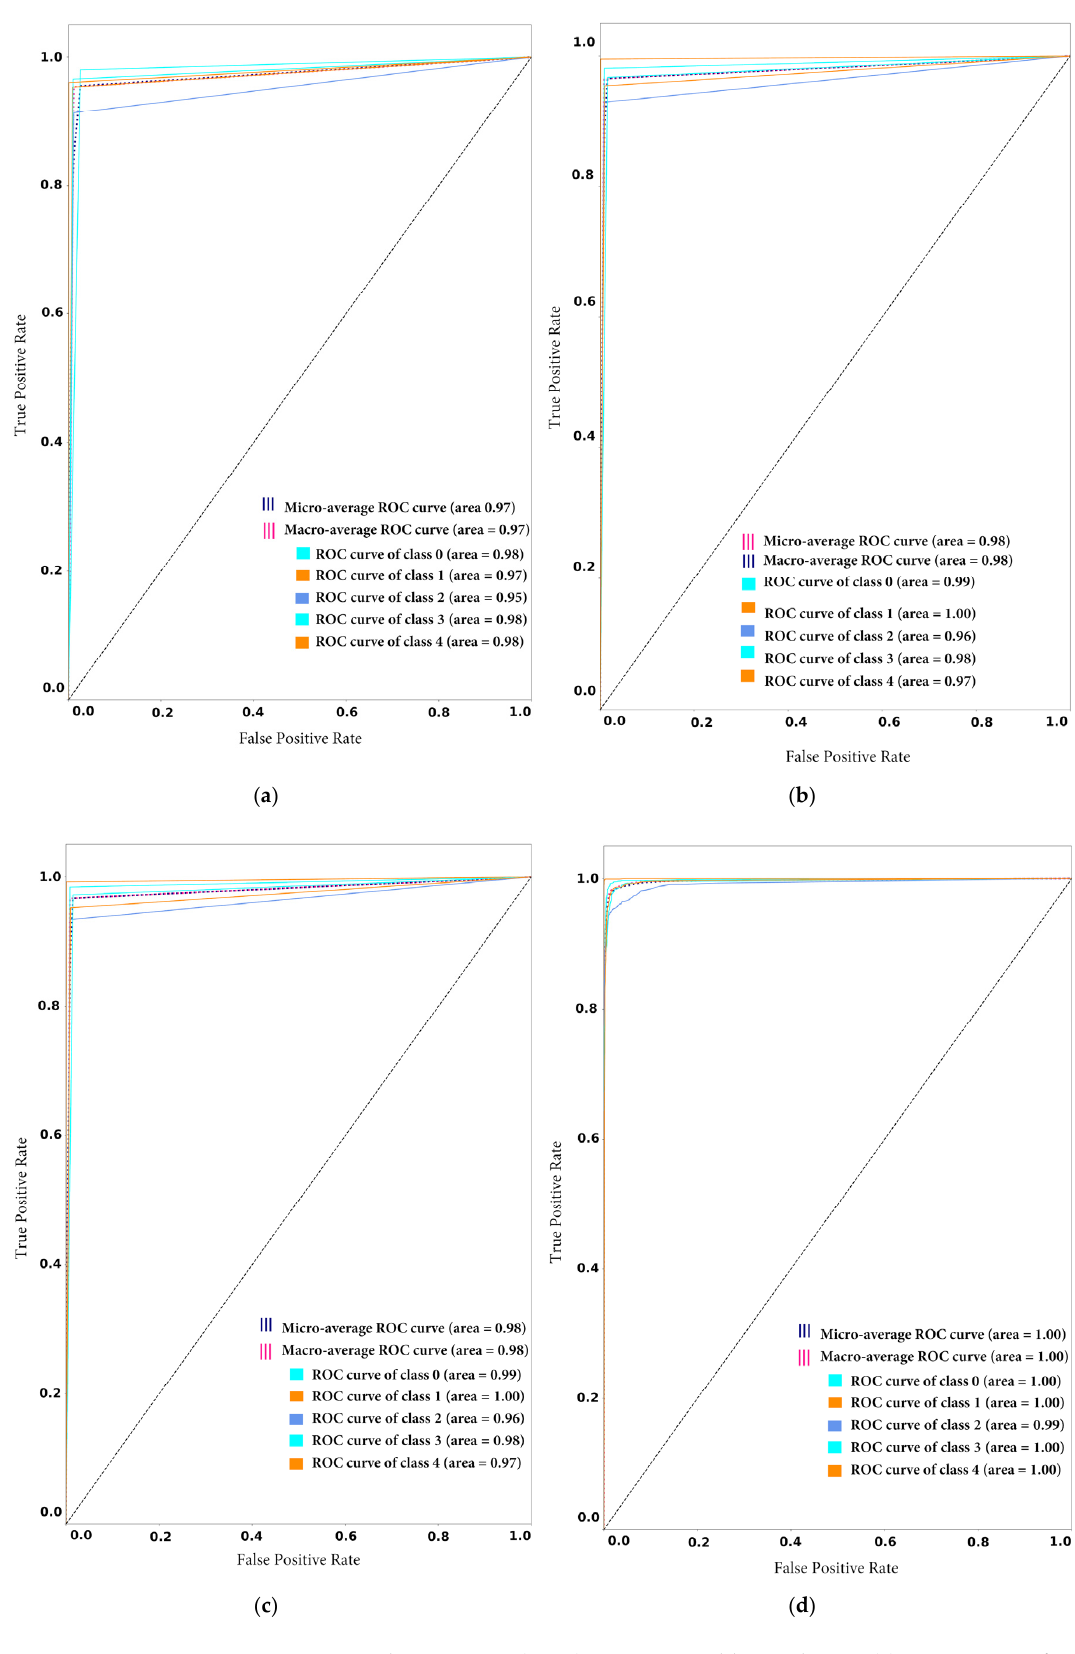
Figure 11. Receiver Operating Characteristic (ROC) curve on stable condition: ( a ) ROC curve of proposed framework ( b ) ROC curve of Ensemble CNN ( c ) ROC curve of Ensemble SVM ( d ) ROC curve of Random